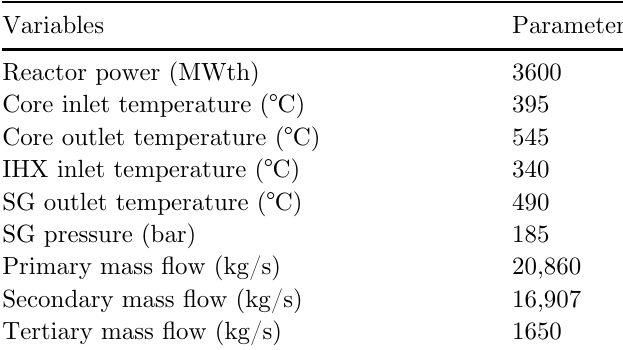
Table 1. Reactor nominal